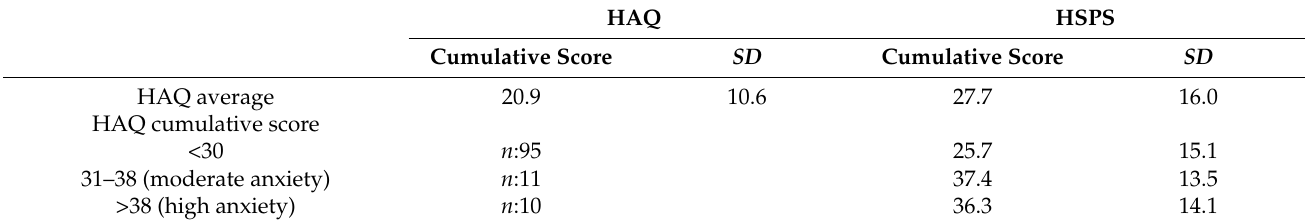
Table 3. Cumulative scores of HSPS in the respective stages of dental fear